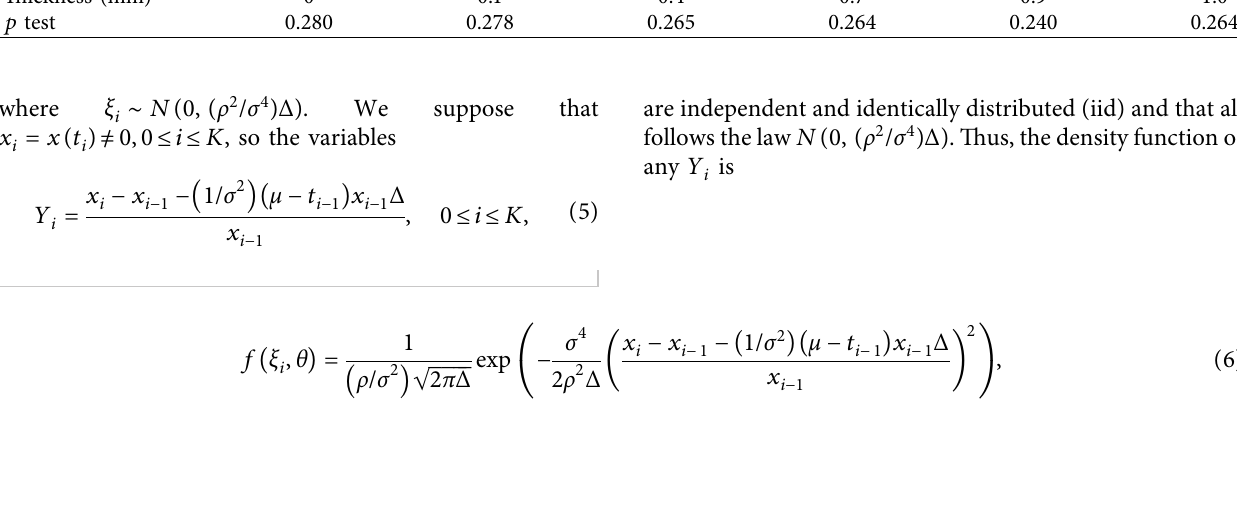
Table 3: Normality test between the von Mises stress and the thickness of elastic piece. Thickness (mm) 0